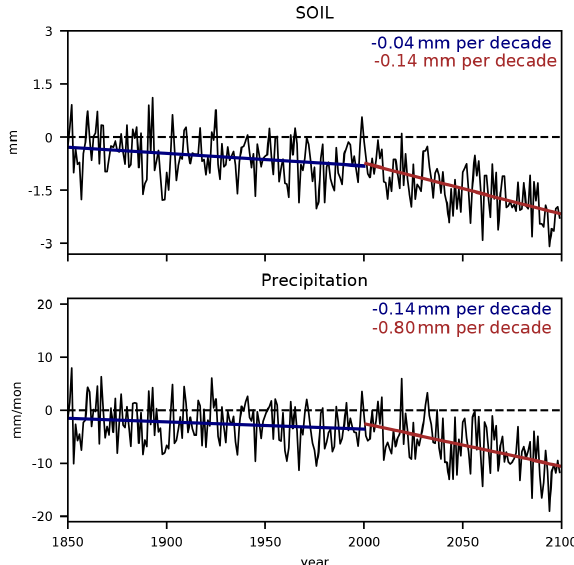
Figure A1. Time series of annual soil moisture (SOIL) and pre- cipitation anomalies from 1850 to 2099CE with respect to the 1000–1849CE means for the detrending method. The least-squares method is applied to two separate time periods: 1850–2000CE and 2001–2099CE. The trends and their values for each period are also